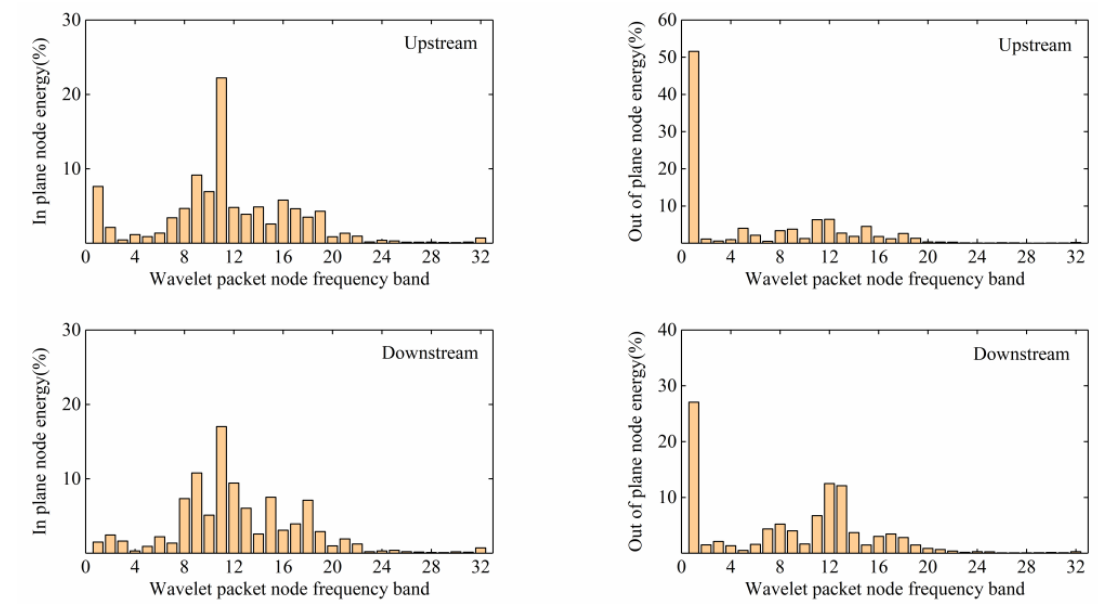
Figure 16. Energy distribution of the cable wavelet packet.